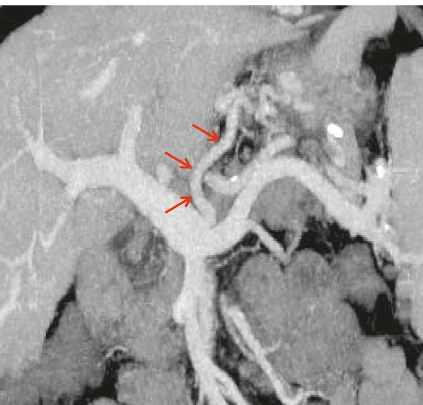
Figure 6: Left gastric vein. A 76-year-old female with a three-year history of autoimmune-related liver cirrhosis presented with recurrent hematemesis and melena. The coronal contrast-enhanced CT scan on the portal vein phase demonstrated the enlarged and tortuous left gastric vein (red arrow) at the lesser curvature of the stomach and the posterior wall of the left hepatic lobe.